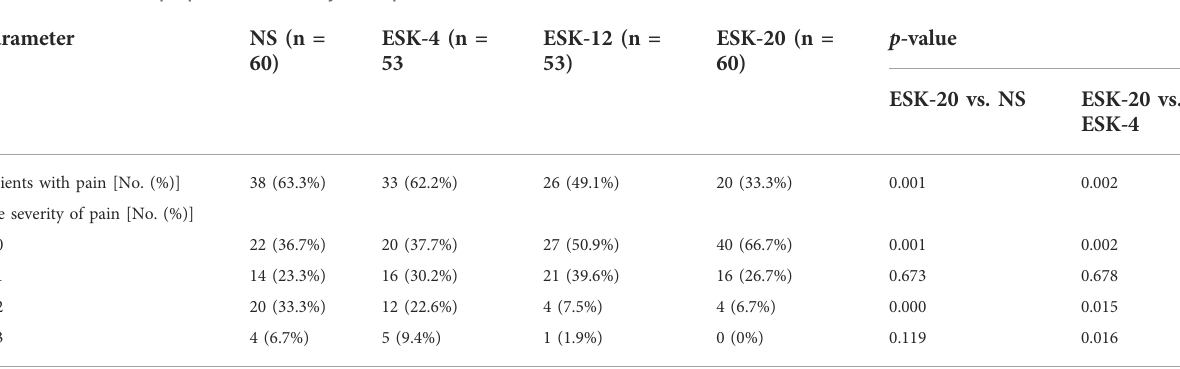
TABLE 2 Incidence of propofol – induced injection pain.